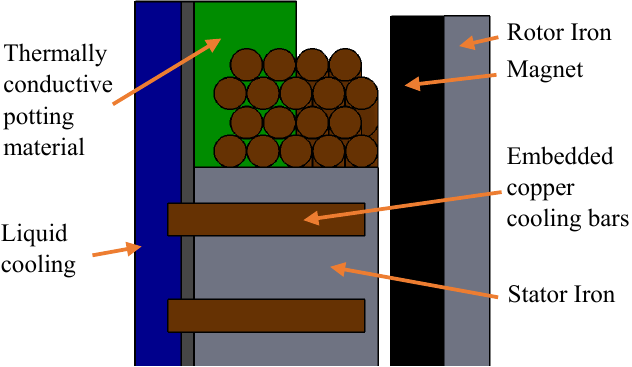
Figure 6. Illustration of intra-iron copper cooling paths and thermally conductive end winding potting material in an axial flux, permanent magnet